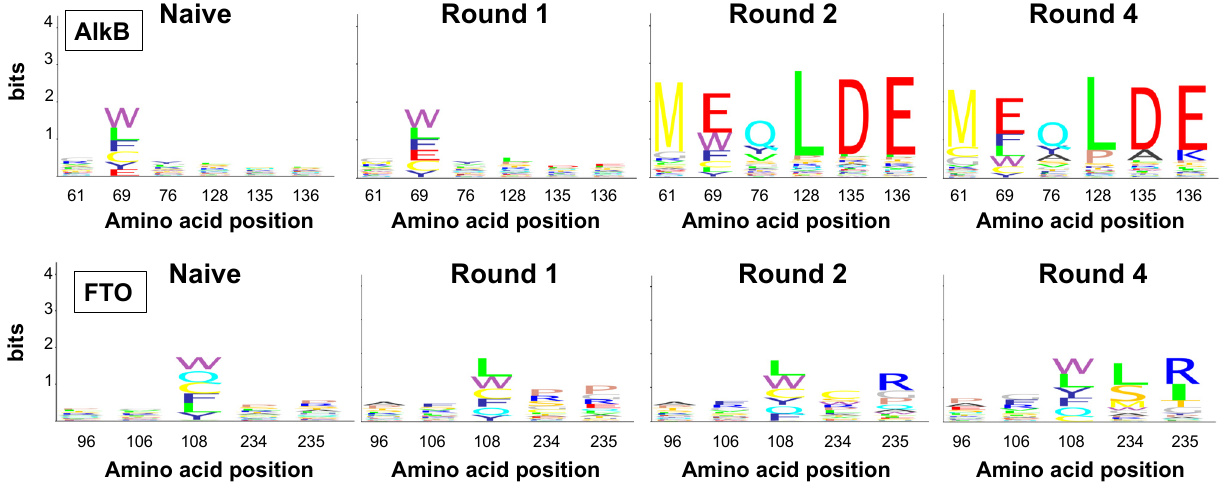
Figure 4. Sequence logos of canonical AlkB and FTO motifs at the six and five randomized positions, respectively, as deduced from Illumina reads. AlkB codon 69 and FTO codon 108 were TDK-randomized (encoding only five residues ((C, F, L, W, Y) and the amber stop codon, which is represented as Gln (Q) as it is efficiently suppressed in display strain TG1). All other triplets were NNK-randomized. Sequence logos were generated with